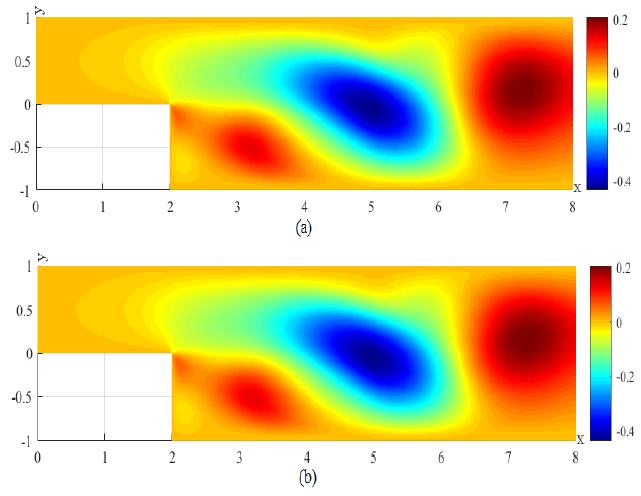
Figure 3. ( a ) The CNMFE solution for v at t = 4. ( b ) The RDRCNMFE solution for v at t = 4.